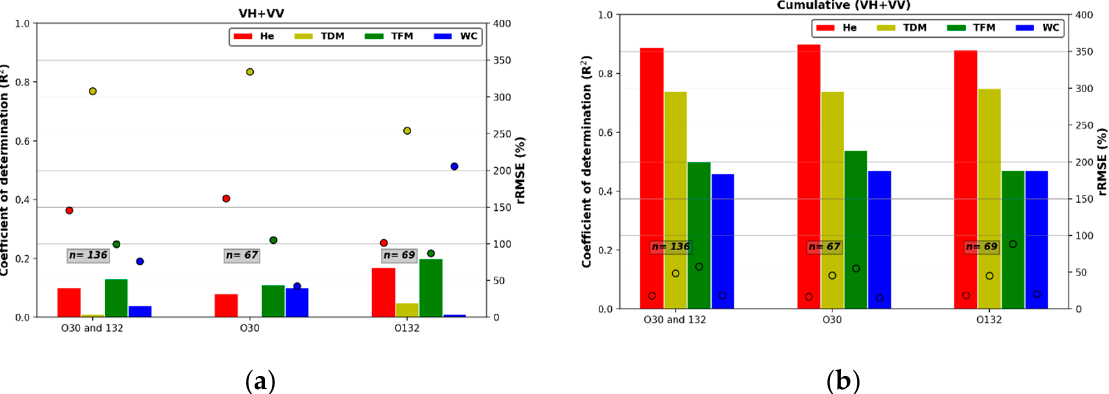
Figure 8. Impact of the orbit pass evaluated through the coefficient of determination and the relative error (rRMSE), calculated for the ( a ) VH + VV and ( b ) cumulative (VH + VV) index, as a function of the He (red bars), TDM (yellow bars), TFM (green bars) and WC (blue bars).